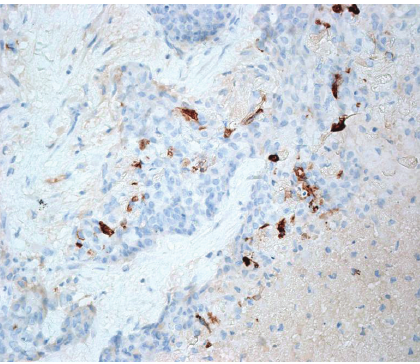
Figure 5: Immunohistochemical expression of high-molecular- weight cytokeratin (SABC technique).